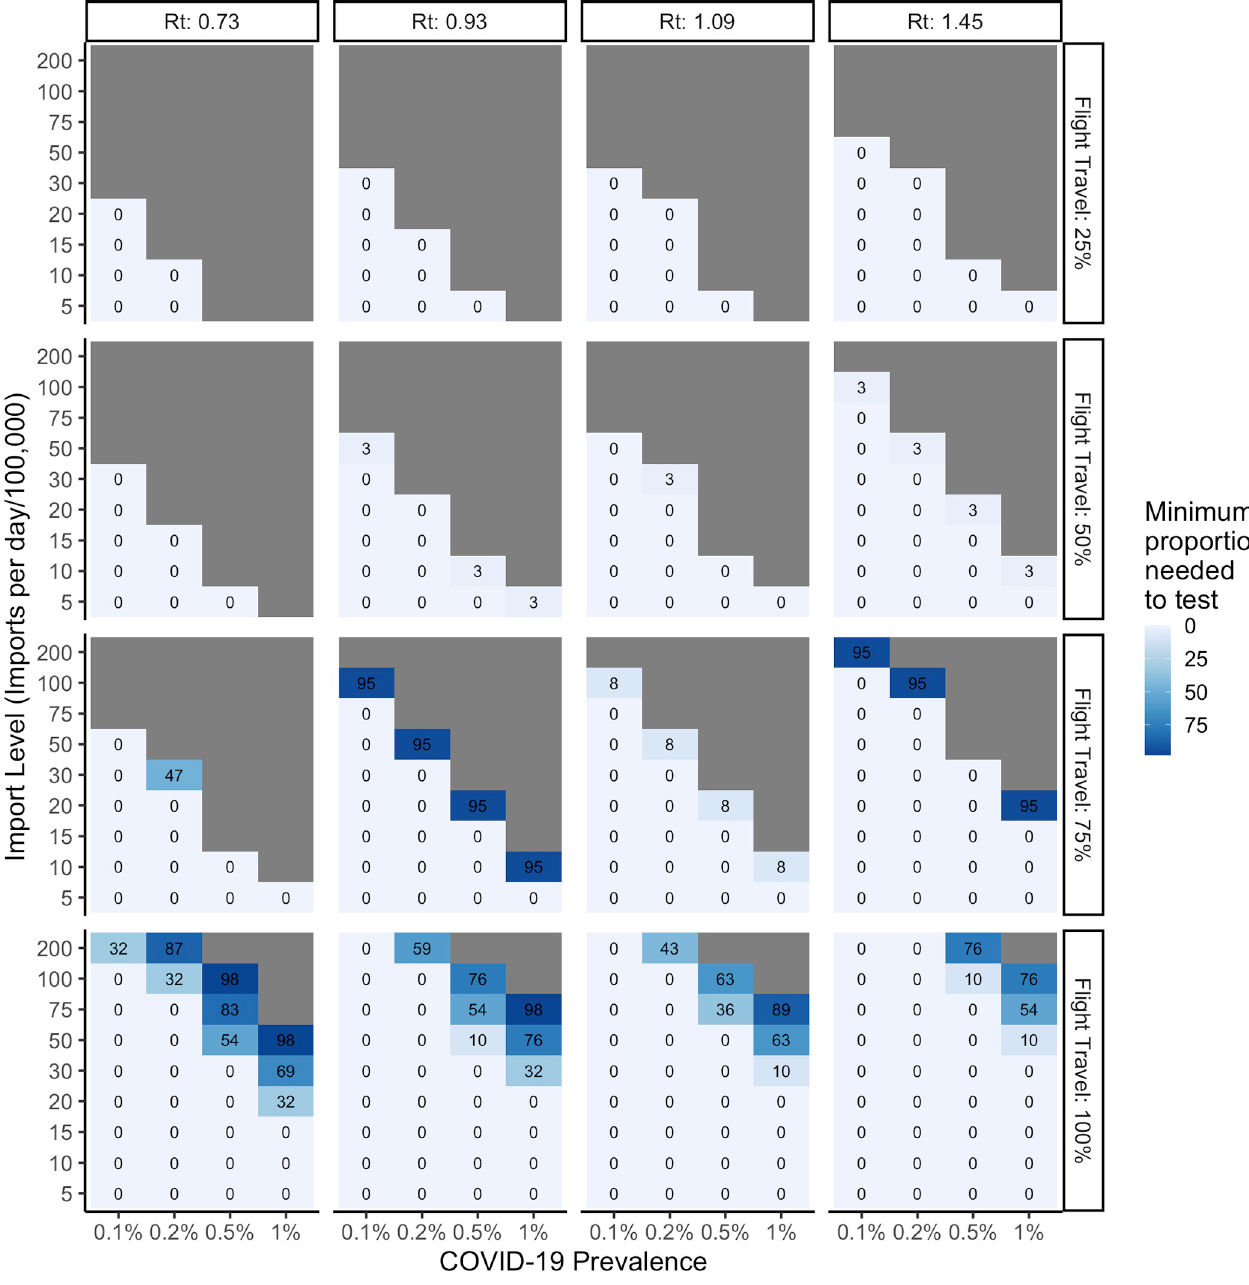
Fig 4. Impact of increasing proportion of flight travel when Ag-RDT screening is only implemented for flight arrivals on the minimum proportion of travelers to be screened with SARS-CoV-2 Ag-RDTs when varied by reproductive number at time t, number of imports per day and SARS-CoV-2 prevalence. Ag-RDT sensitivity is set to